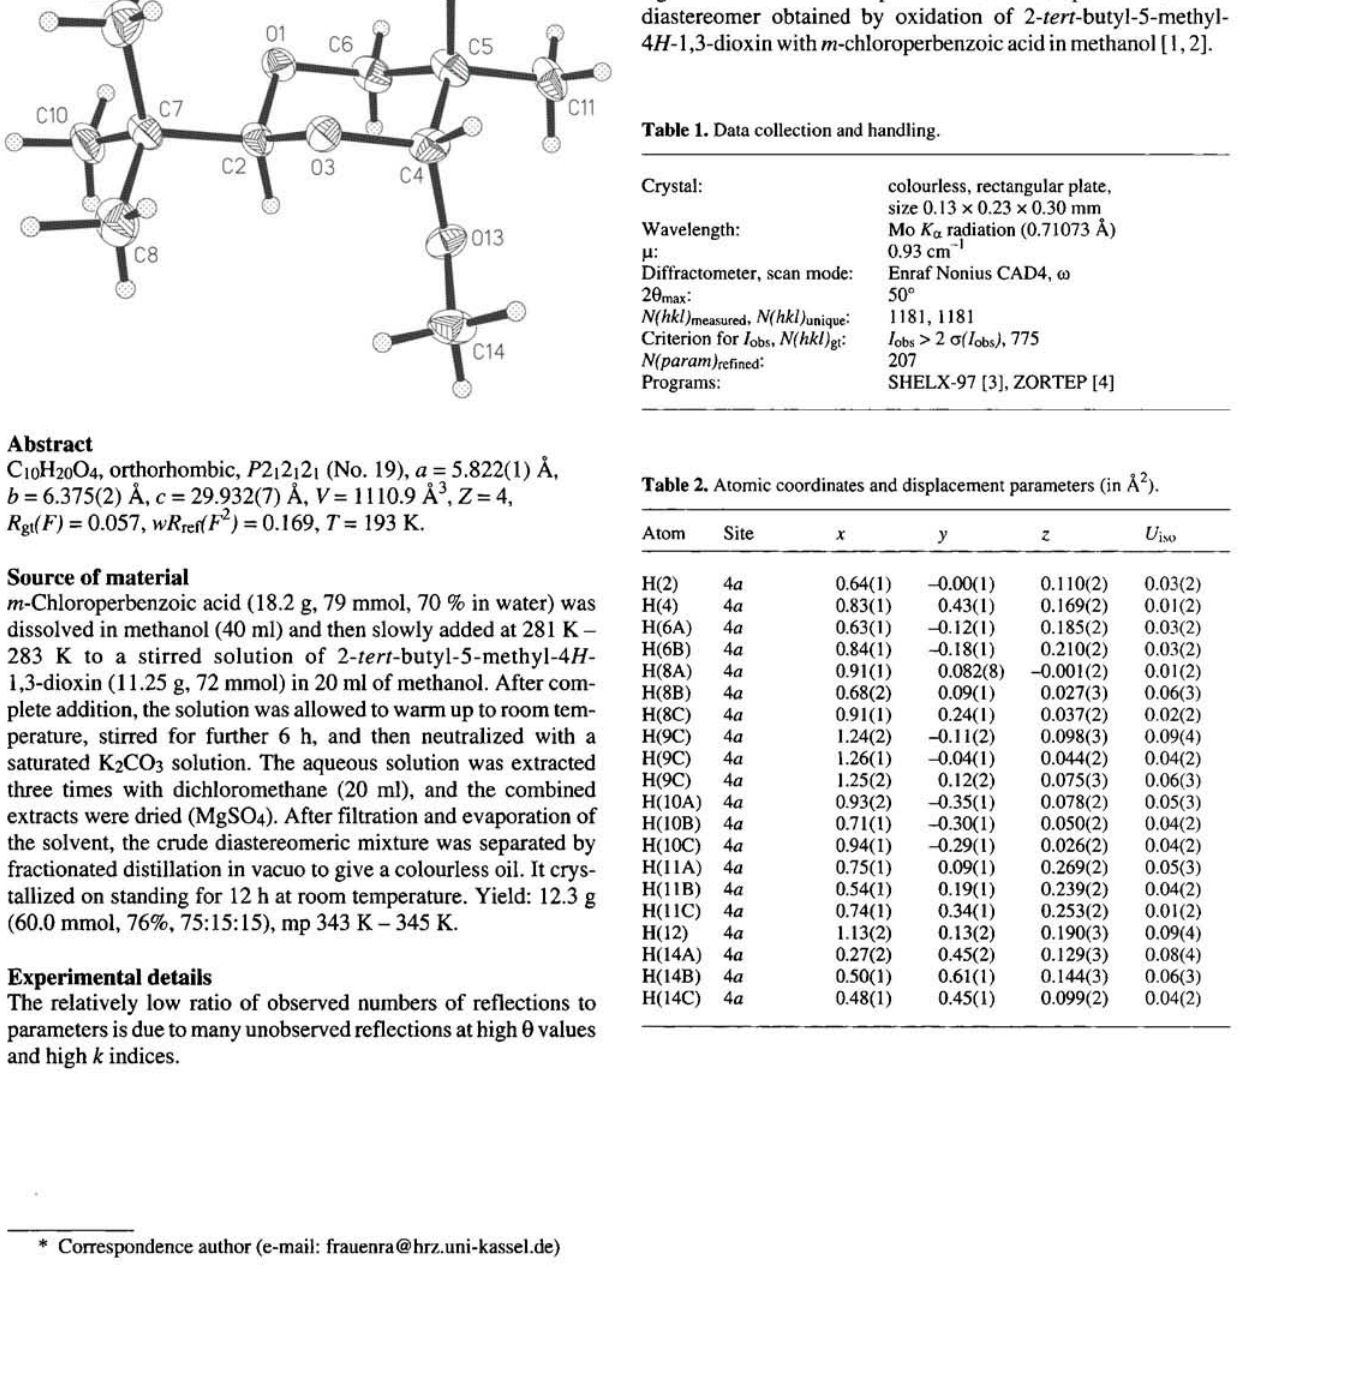
Table 1. Data collection and handling.